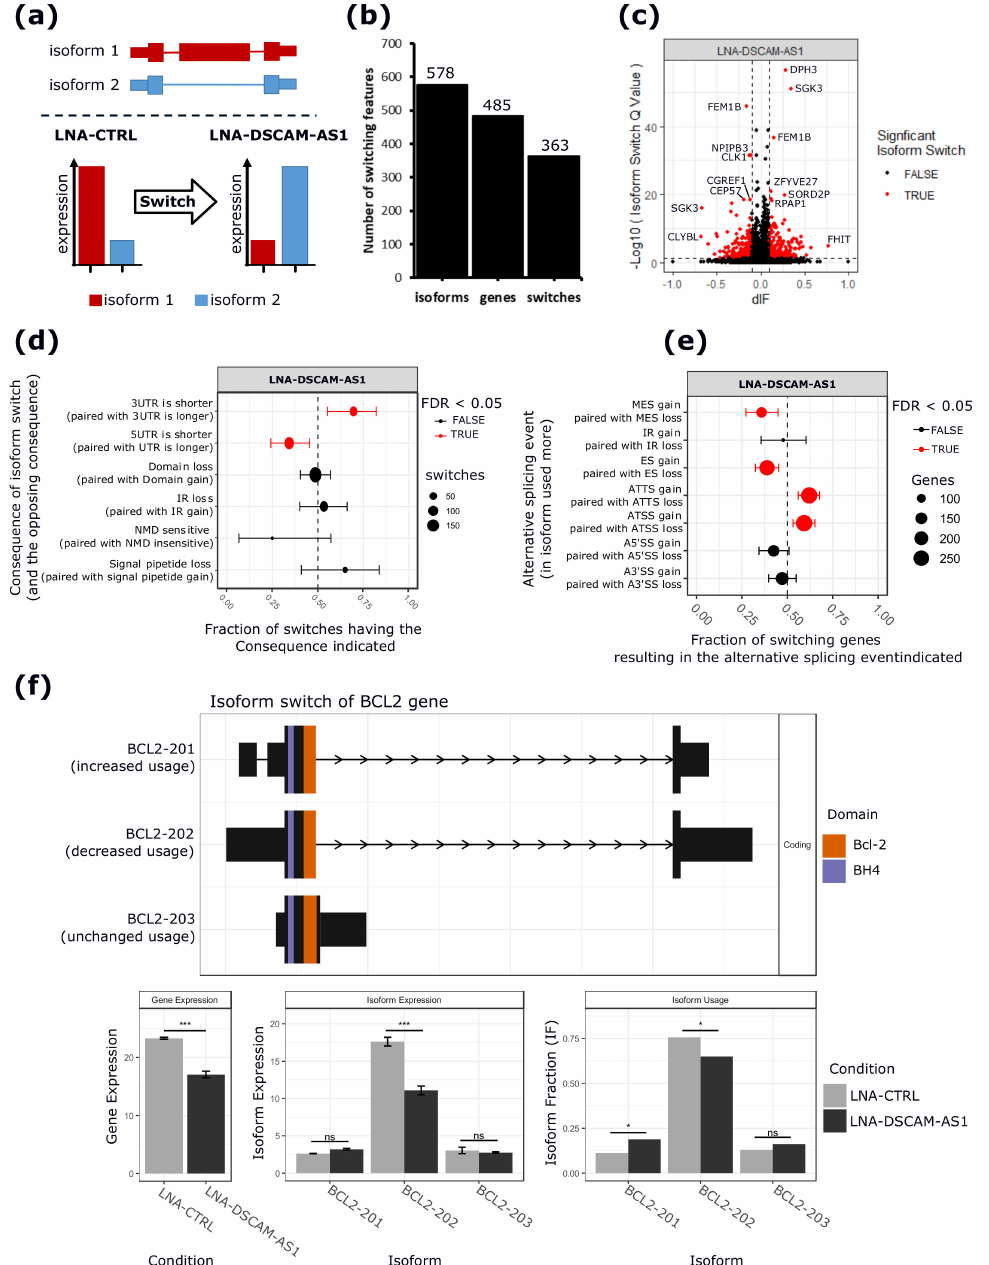
Figure 3. Isoform switching analysis. ( a ) Schematic overview of isoform switching concept used by the IsoformSwitchAnalyzeR tool [27]. An isoform switching event is defined as a case where the relative contribution of the isoforms to the parent gene expression changes significantly between conditions. ( b ) Bar plot reporting the number of isoforms and genes showing significant switching events upon DSCAM-AS1 silencing. ( c ) Volcano plot showing the di ff erential isoform fraction (dIF) and the significance of the switching isoforms. In red are reported those isoforms with a | dIF | > 10% and an FDR < 0.05. ( d ) Summary plot showing the enrichment of specific isoform features (consequence) resulting from the observed isoform switching events. From left to right, the x-axis of the plot shows the fraction of switches having the indicated consequence, where < 0.5 means depleted while > 0.5 means enriched upon DSCAM-AS1 silencing. ( e ) AS event enrichment involved in isoform switches upon DSCAM-AS1 silencing. The x-axis shows the fraction of genes showing enrichment of a specific AS event upon DSCAM-AS1 silencing (from left to right). ( f ) Isoform switching event of the BCL2